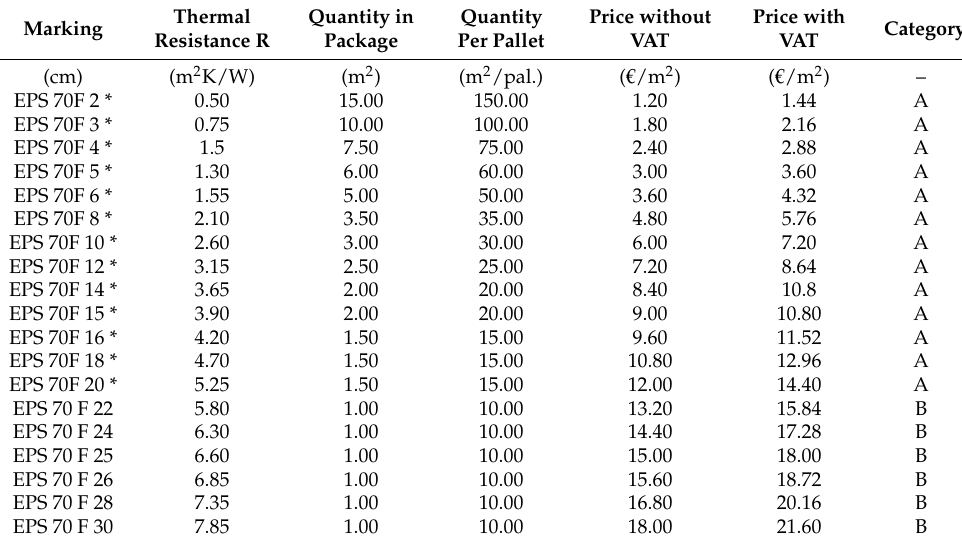
Table 2. Price list of thermal insulation and accessories ISOVER [30].